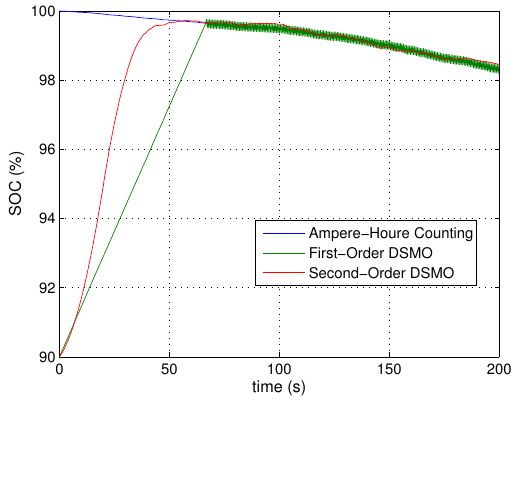
Figure 10. SOC estimation results with unknown the initial